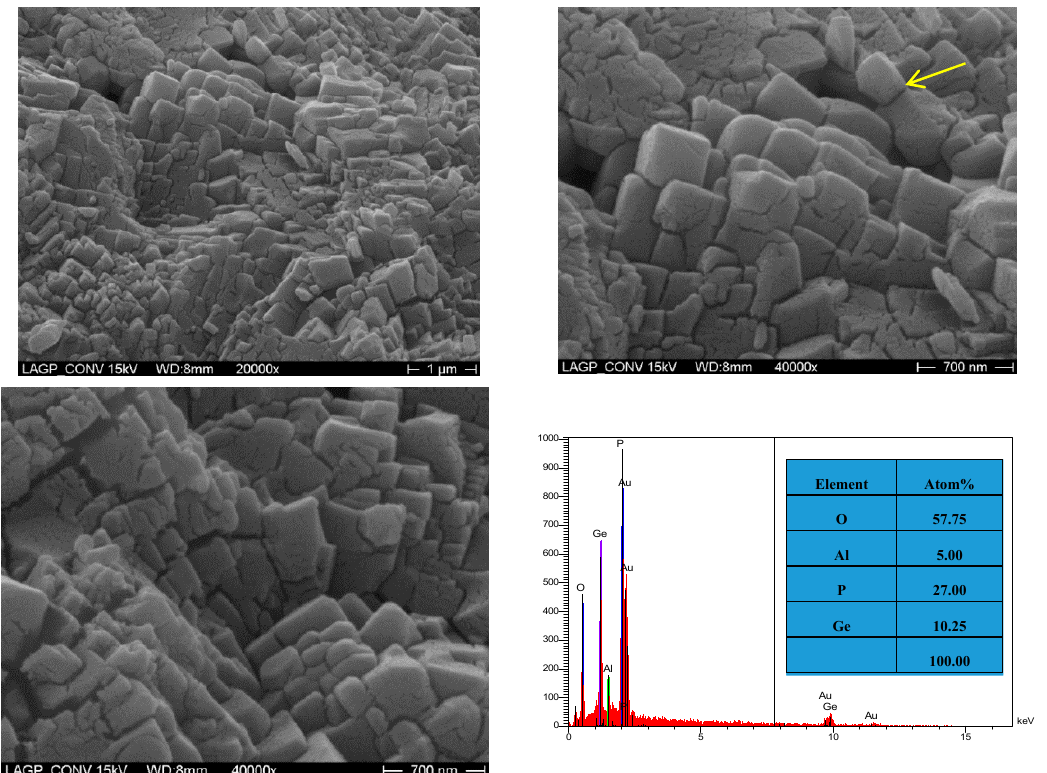
Figure 7. SEM micrographs with EDX data of LAGP glass-ceramics sample heat-treated at 800 °C for 6 h using conventional heating.